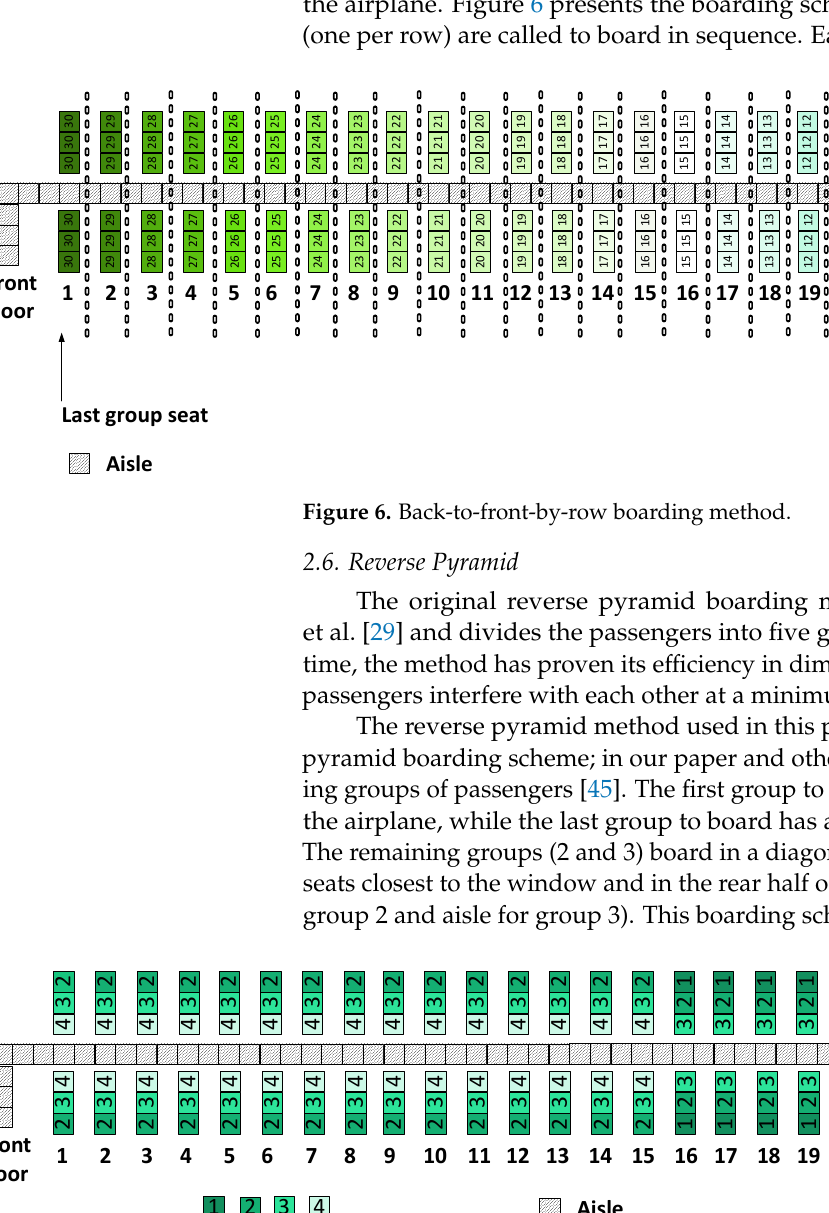
Figure 5. Back-to-front-by-5-groups.